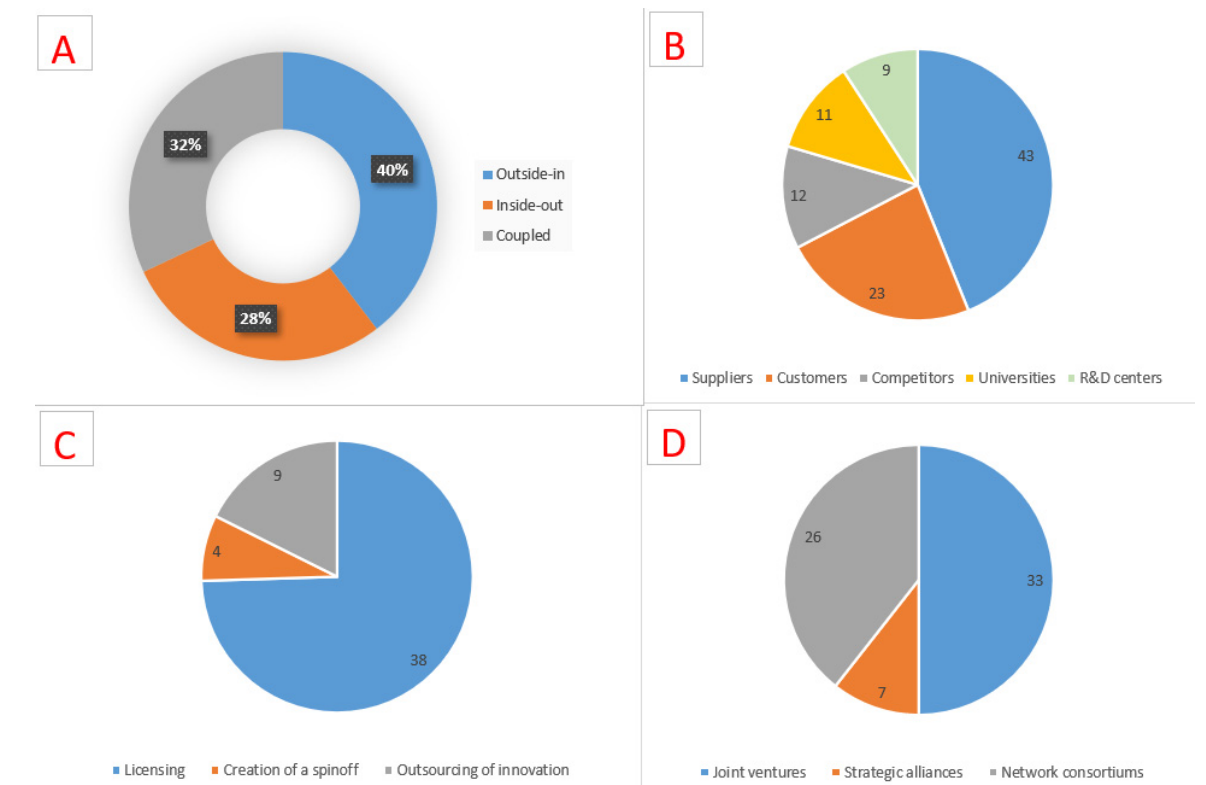
Figure 1. Infographic of open-innovation practices.